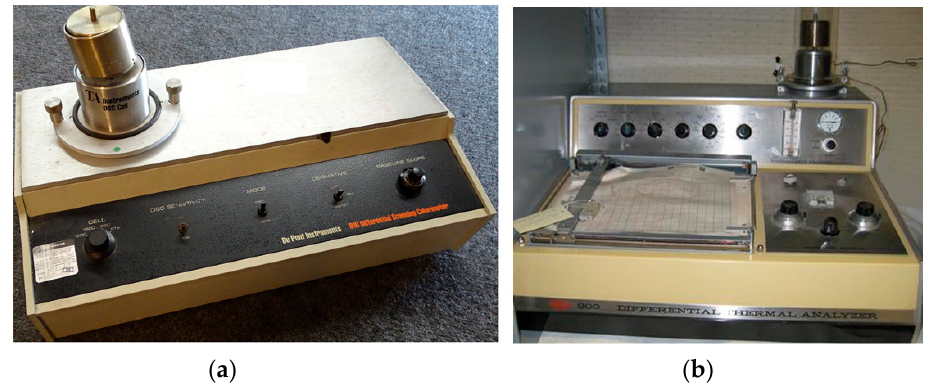
Figure 6. Differential thermal analyzer ( a ) and differential scanning calorimetry (DSC) analyzer ( b ) for the measurement of interphase thickness.